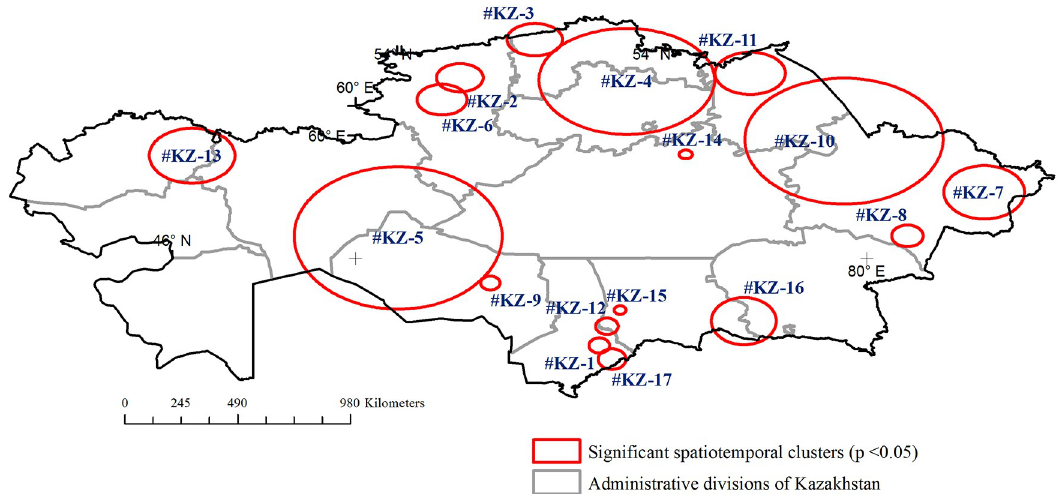
Fig 5. Spatiotemporal clustering of animal Anthrax cases in Kazakhstan (time: 1933–2014). Clusters were detected using the space-time permutation model of the spatial scan statistic with the spatial- and time-windows set to 10% and 5%, respectively. Clusters are numbered according to the order of the start date of the